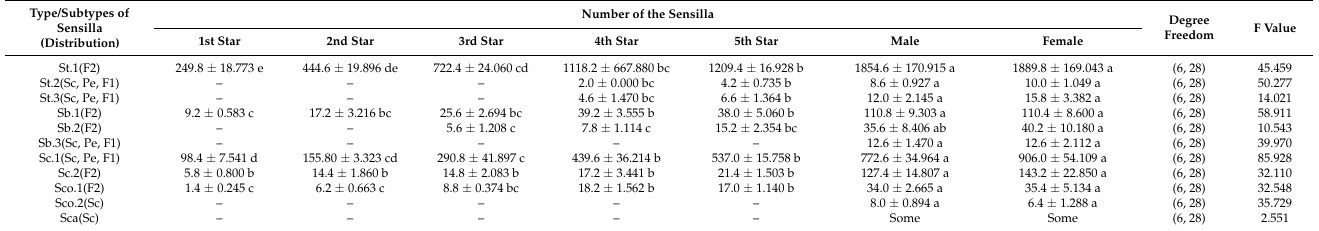
Table 1. Number and distribution of sensilla in the antennae of N. meleagris